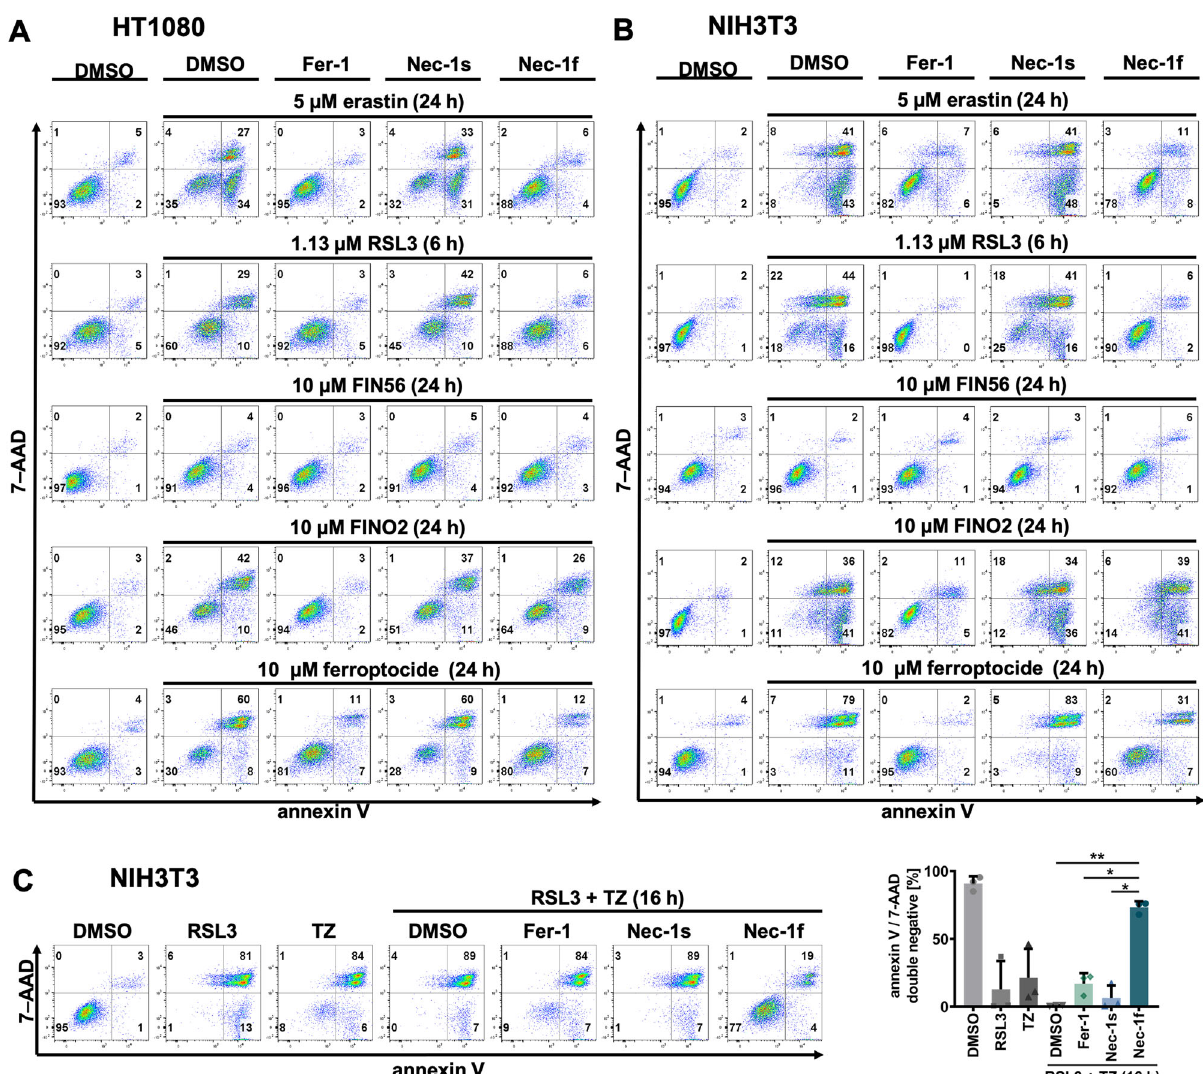
Fig. 3 Nec-1f inhibits ferroptosis. A HT1080 cells were treated for 6 or 24 h with ferroptosis inducers (FINs) or ferroptocide in the presence of Fer-1 (1 µ M), Nec-1s (30 µ M) or Nec-1f (30 µ M), respectively, as indicated. B NIH3T3 cells were treated as in ( A ). C NIH3T3 cells were treated for 16 h with either 1.13 µ M RSL3 alone, TZ alone, or the combination of RSL3 plus TZ. While Fer-1 or Nec-1s fail to rescue NIH3T3 cells from necrosis, Nec-1f does. Plots show stainings of 7-aminoactinomycin (7-AAD) and annexin V ( n = 3). The bar graph shows mean + / − SD. Statistical analysis was performed using one-way ANOVA (post hoc Tukey ’ s). * p < 0.05, ** p <